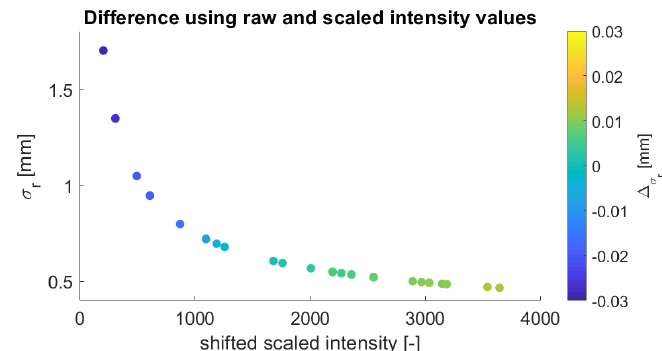
Figure 11. Comparison of the range precision calculated with the raw and scaled intensity values by inserting these values in the estimated